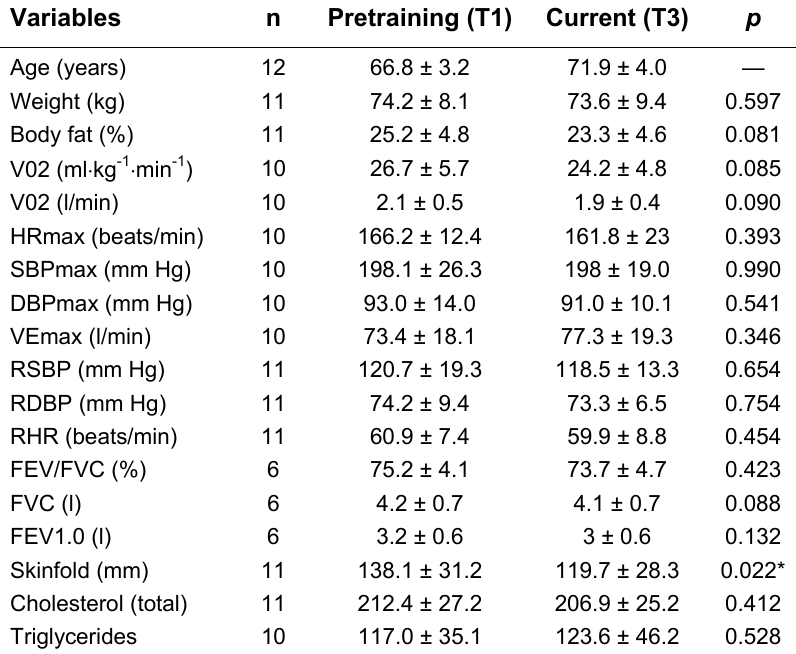
Pretraining and Current Measurements for Highly Active